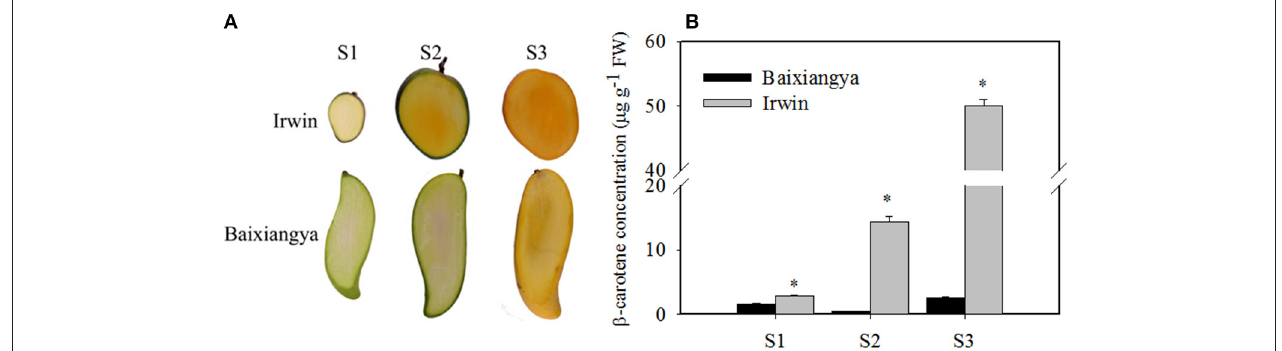
FIGURE 2 | Changes in the color (A) and β -carotene concentration (B) in the flesh of “Baixiangya” and “Irwin” during fruit development and ripening. Fruit development and ripening were divided into three stages: S1, early development stage; S2, harvest stage; and S3, fully ripe stage. A black asterisk indicates a significant change ( p ≤ 0.01) between two cultivars.